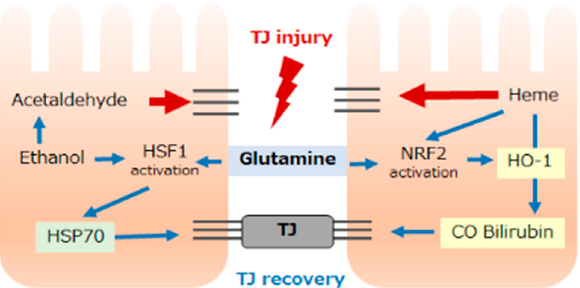
Figure 3. Putative mechanisms through which glutamine protects barrier function in the intestinal epithelium. Ethanol causes TJ injury via the metabolite acetaldehyde, followed by TJ recovery through heat shock protein 70 (HSP70) induced by heat shock factor 1 (HSF1) activation (left). In contrast, excess intracellular heme disrupts TJ, followed by HO-1 induction, which produces the metabolites CO and bilirubin, supporting TJ recovery. Supplementation with glutamine enhances HSF1 and NF-E2-related factor 2 (NRF2) activation, resulting in HSP70 or HO-1 induction, respec- tively.